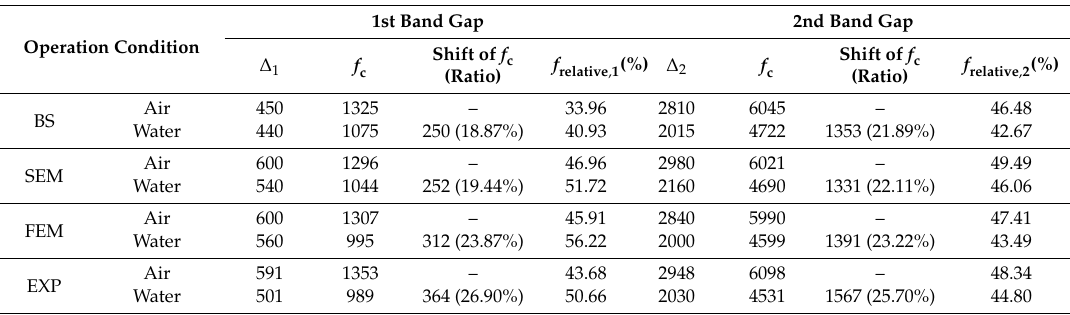
Table 2. Widths of the band gaps, center frequencies, percentage of shift of the center frequency, and relative size of the band gap in the displacement transmission of the PC beam. a